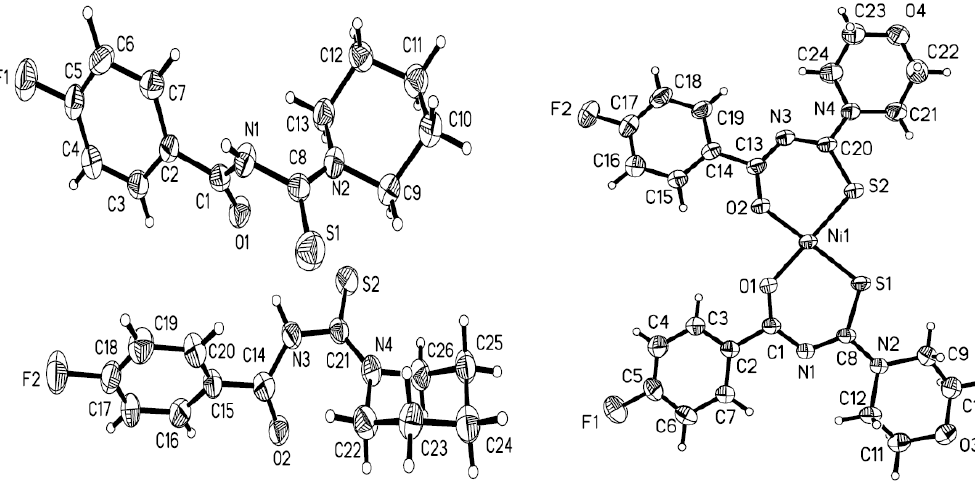
Figure 2. Molecular structures of HL3 and [Ni(L3)